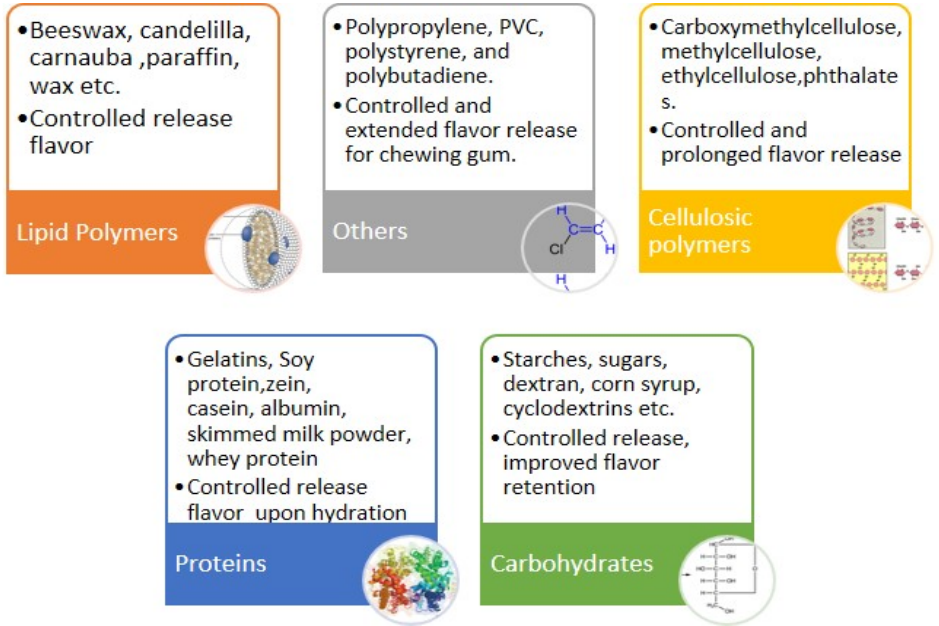
Figure 5. Polymers used for flavor microencapsulation in Medicated Chewing Gums.